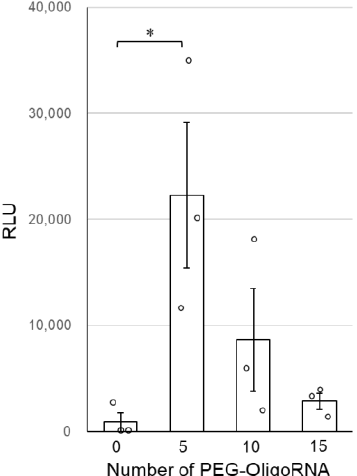
Figure 5. Transfection efficiency of n *PEG-mRNA in cultured cells. Data are shown as average mean ± SEM. Each dot refers to an individual measurement ( n = 3). Statistical difference was analyzed by ANOVA followed by Dunnett’s test as compared with the 0 *PEG-mRNA. * p < 0.05.